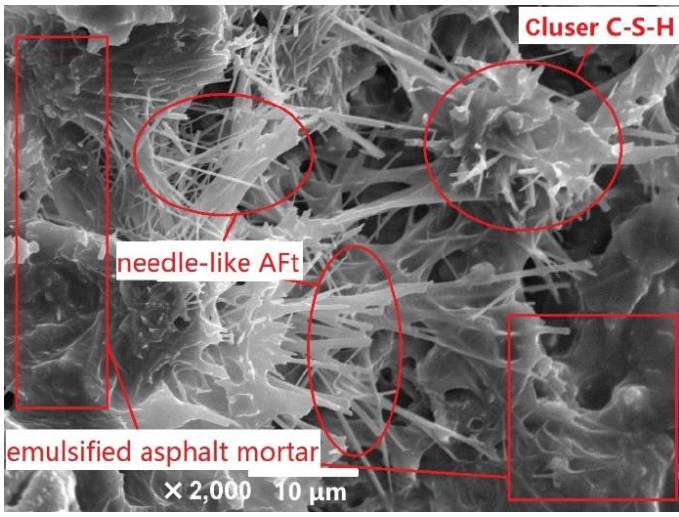
Figure 6. Interaction between the hydration products and asphalt mortar of the G1 mixture.